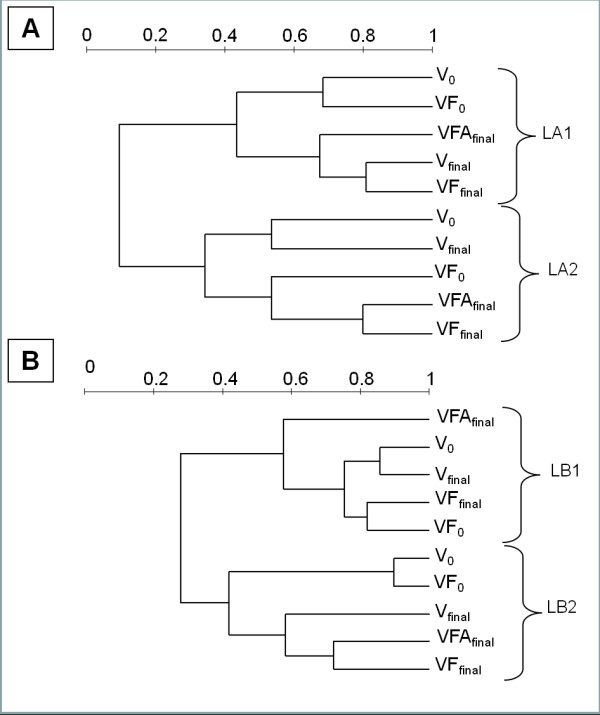
Cluster analysis of DGGE profiles based on band position and intensity. Scale bars indicated the Bray-Curtis similarity index in Lake Annecy (A) and Lake Bourget (B). V0 and VFinal, treatment Viruses+Bacteria at the beginning and the end of experiments; VF0 and VFfinal, treatment Viruses+Bacteria+Flagellates at the beginning and the end of experiments, VFAfinal, treatment Viruses+Bacteria+Flagellates+Autotrophs at the end of experiments.